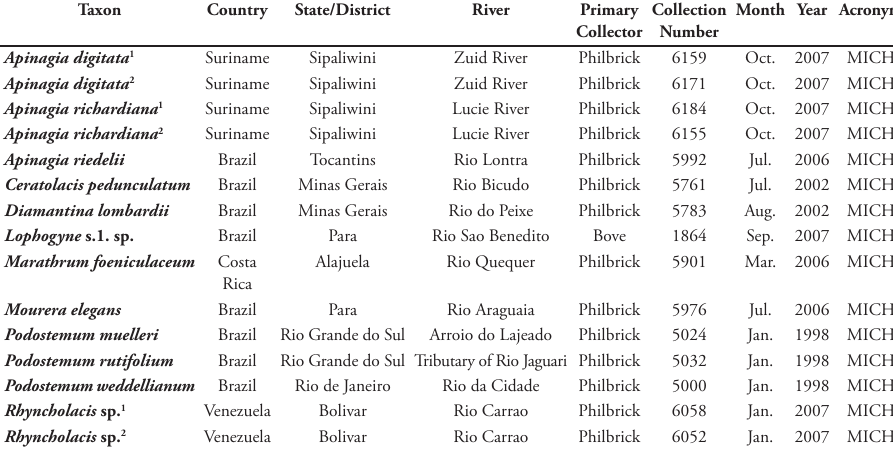
Table 1. Voucher specimens of Podostemaceae listing taxon, country, state/district, river, primary collec- tor, collection number, month, year and acronym (http://sweetgum.nybg.org/science/ih/) of the herbari- um where the voucher is located. Super scripts are used to differentiate between replicate